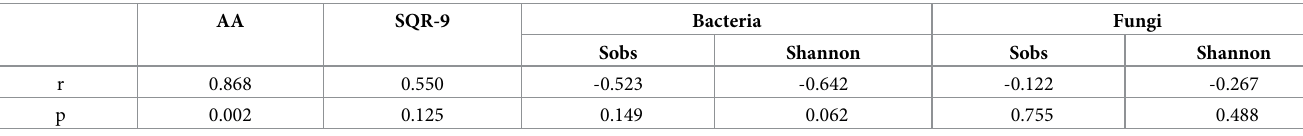
Table 1. Pearson correlation analysis between different indicators and crop yields. AA SQR-9 Bacteria Fungi Sobs Shannon Sobs Shannon r 0.868 p 0.002 0.125 Note: AA, amino acids fertilizer; SQR9, functional PGPR strain SQR9. The index was constructed by 0 when the factor was inexistence and 1 when the factor was